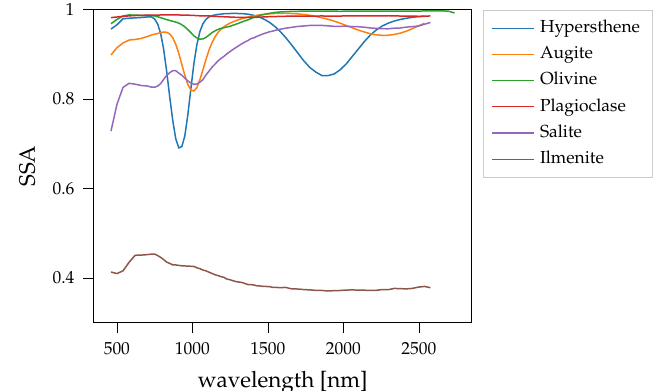
Figure 5. The endmembers for the experiments in Sections 3.1 and 3.3. All the endmembers have a grain size of 0–45 µ m. The RELAB IDs are: OPX is the hypersthene AG-TJM-009; CPX Type B is the augite AG-TJM-010; OLV is the olivine PO-EAC-056; PLG is the plagioclase PL-EAC-029; CPX Type A is the pyroxene diopside PP-ALS-105; ILM is the ilmenite SC-EAC-034. The generated mixtures are based on a mare composition of the endmembers of 10 wt.% hypersthene, 40 wt.% augite, 5 wt.% olivine, 30 wt.% plagioclase, and 15 wt.% diopside. The ilmenite abundance is varied between 0 wt.% and 16 wt.% and the remaining